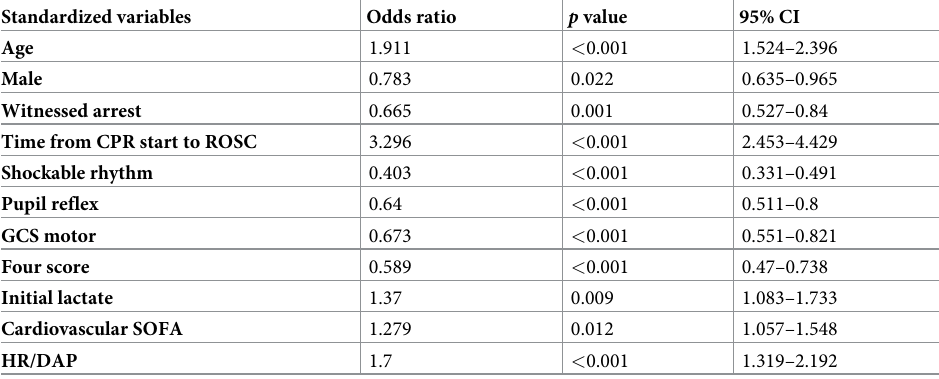
Table 2. Multi-variable analysis to predict poor neurological